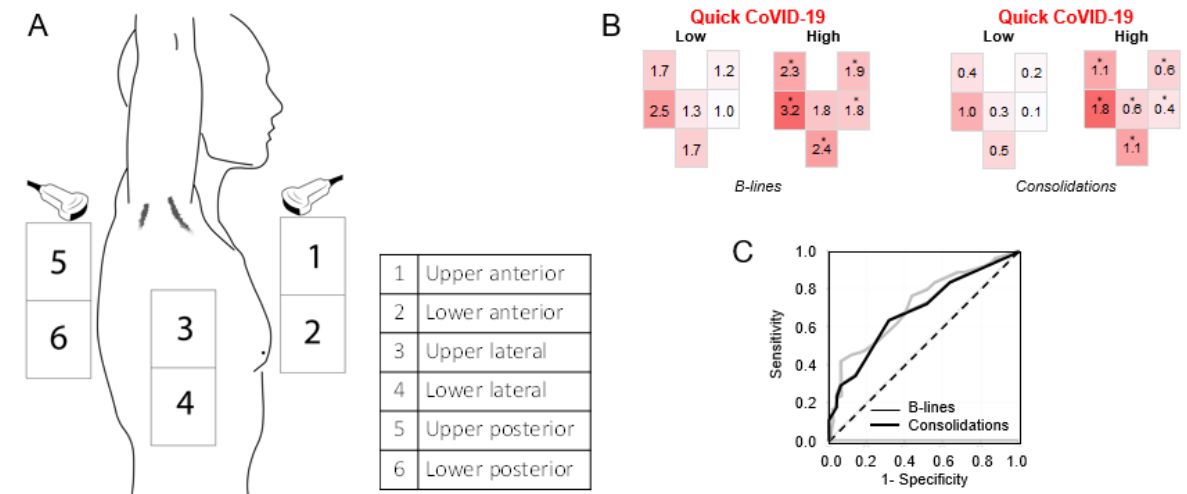
Figure 1. Graphical representation of lung ultrasound (LUS) patterns. ( A ) Geographical location of the six lung fields. ( B ) Average score for B-lines and consolidation in each of the lung field in patients divided according to high or low quick coronavirus disease 2019 (COVID-19) severity index (* p < 0.05 high versus low). ( C ) Receiver Operating Characteristics (ROC) curve for the discrimination of high quick COVID-19 severity index (qCSI) by B-line and consolidation scores.